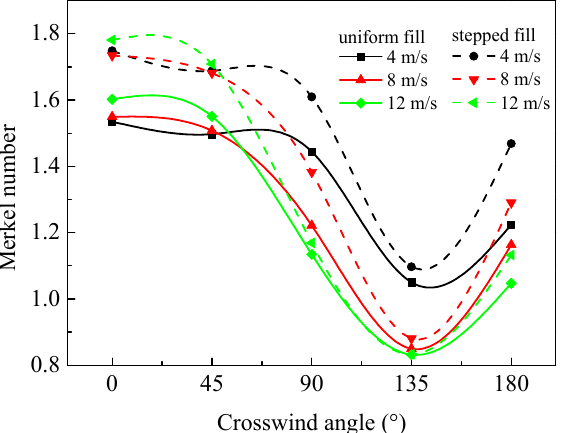
Figure 13. The changes of Merkel number with different crosswind angles.